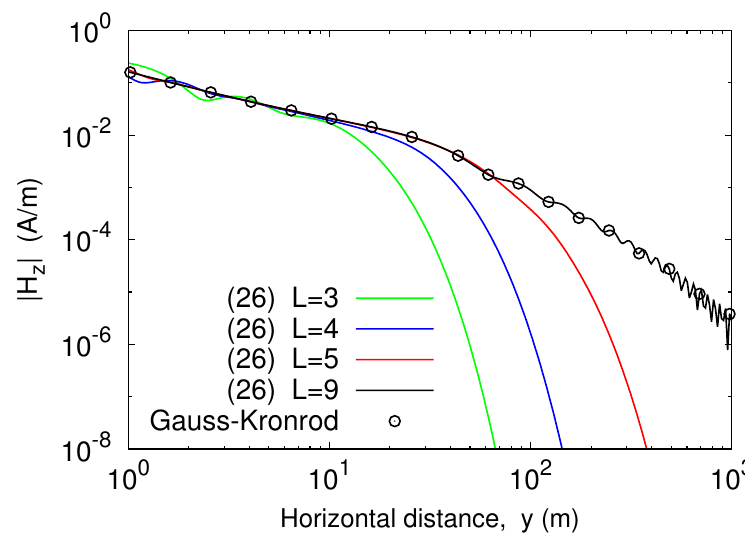
Figure 3. Amplitude of H z against the horizontal distance from the line source.